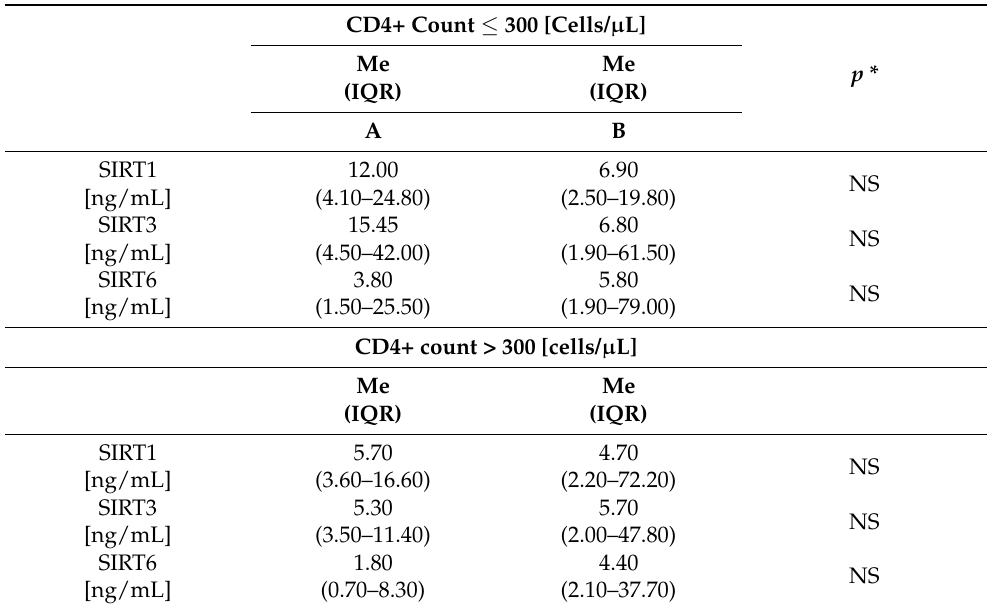
Table 4. Results for SIRT1, SIRT3 and SIRT6 in the plasma of HIV-infected men before cART ( A ) and after cART ( B ) subgrouped according to LT CD4+ count.